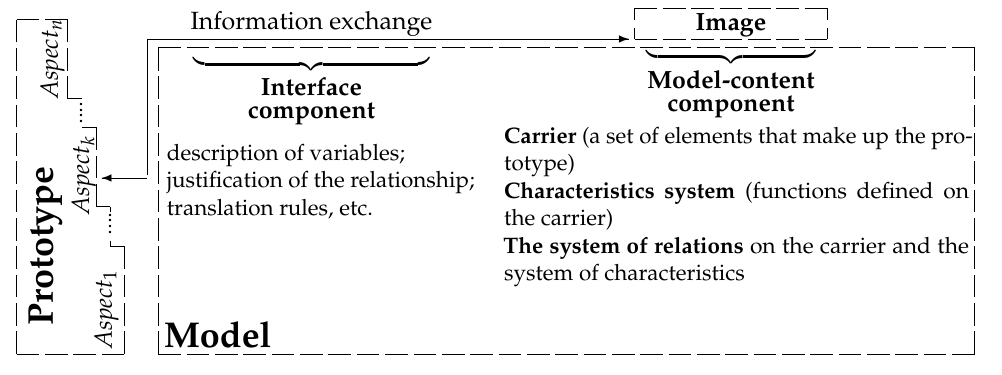
Figure 1. Illustration for the formal-constructive interpretation of the concept of “model”.